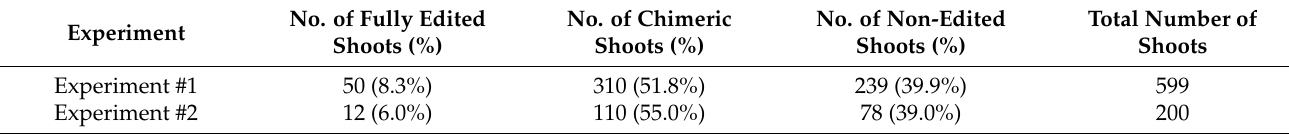
Table 1. Estimated gusA editing frequencies based on the histochemical GUS staining of hygromycin- resistant T 0 transgenic tobacco shoots transformed with the P35S-Cas9-GUS-gRNAs. Edited shoots or tissues refer to those that showed no visible blue